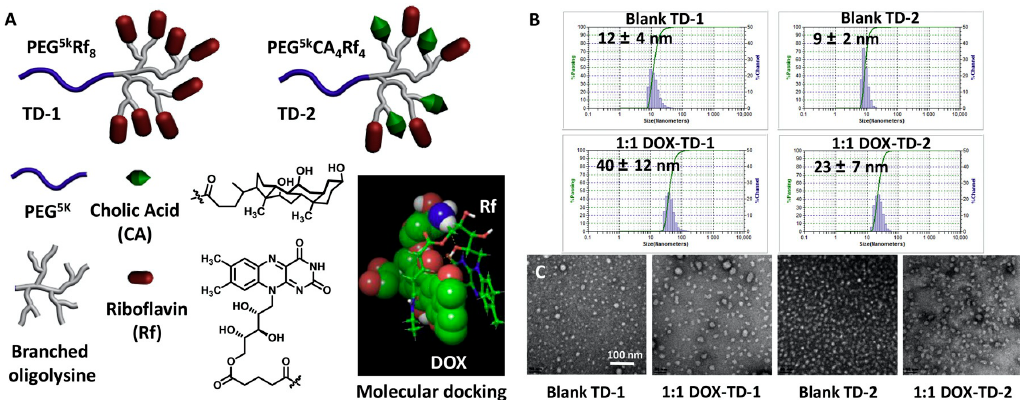
Figure 7. PEG-polylysine dendrimers ( A ), nanoparticle sizes ( B ), and TEM images ( C ) of empty and DOX-loaded assemblies. Reprinted with permission from [177]. Copyright 2017 Elsevier.